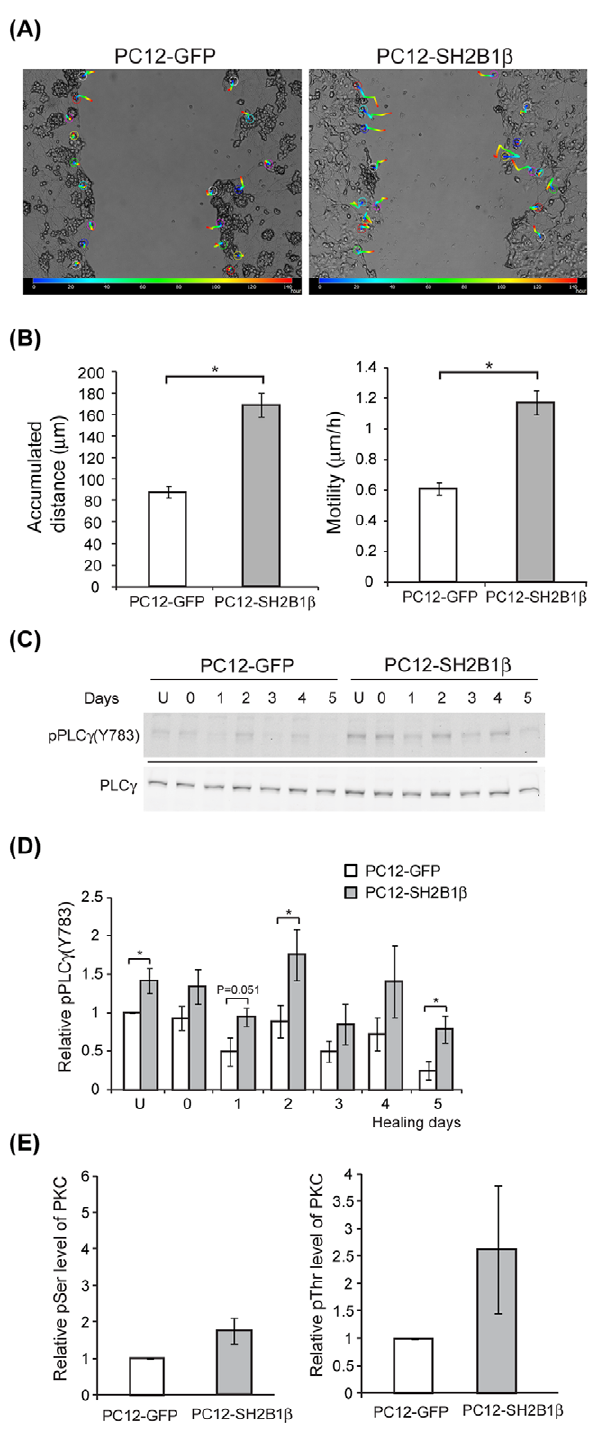
Figure 4. Increased cell migration of PC12-SH2B1 b cells during wound healing associates with elevated pPLC c 1 and pPKC. PC12-GFP and PC12-SH2B1 b cells were differentiated and subjected to wound healing as described in Figure 1. (A) Movement of cells around the wounded gaps was tracked as described in the Materials and Methods during healing for 6 days. The color lines represent the migration path of cells from time 0 (blue) to 144 h (red) during healing. (B) The accumulated distances and motility during time 0–144 h were calculated. Cell motility (rate of cell migration) is defined as accumulated distance/time. Values are mean 6 S.E.M. from